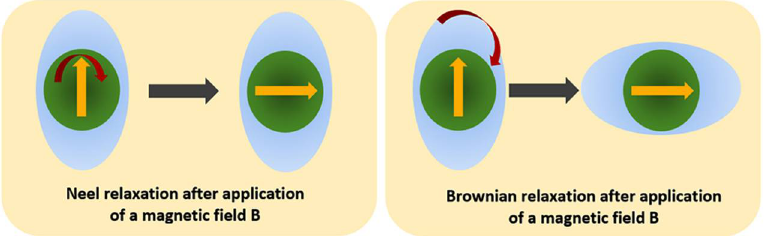
Figure 5. Néel relaxation is the rotation of magnetic moment inside a stationary MNP. Brownian relaxation is the rotation of entire MNP along with the magnetic moment .